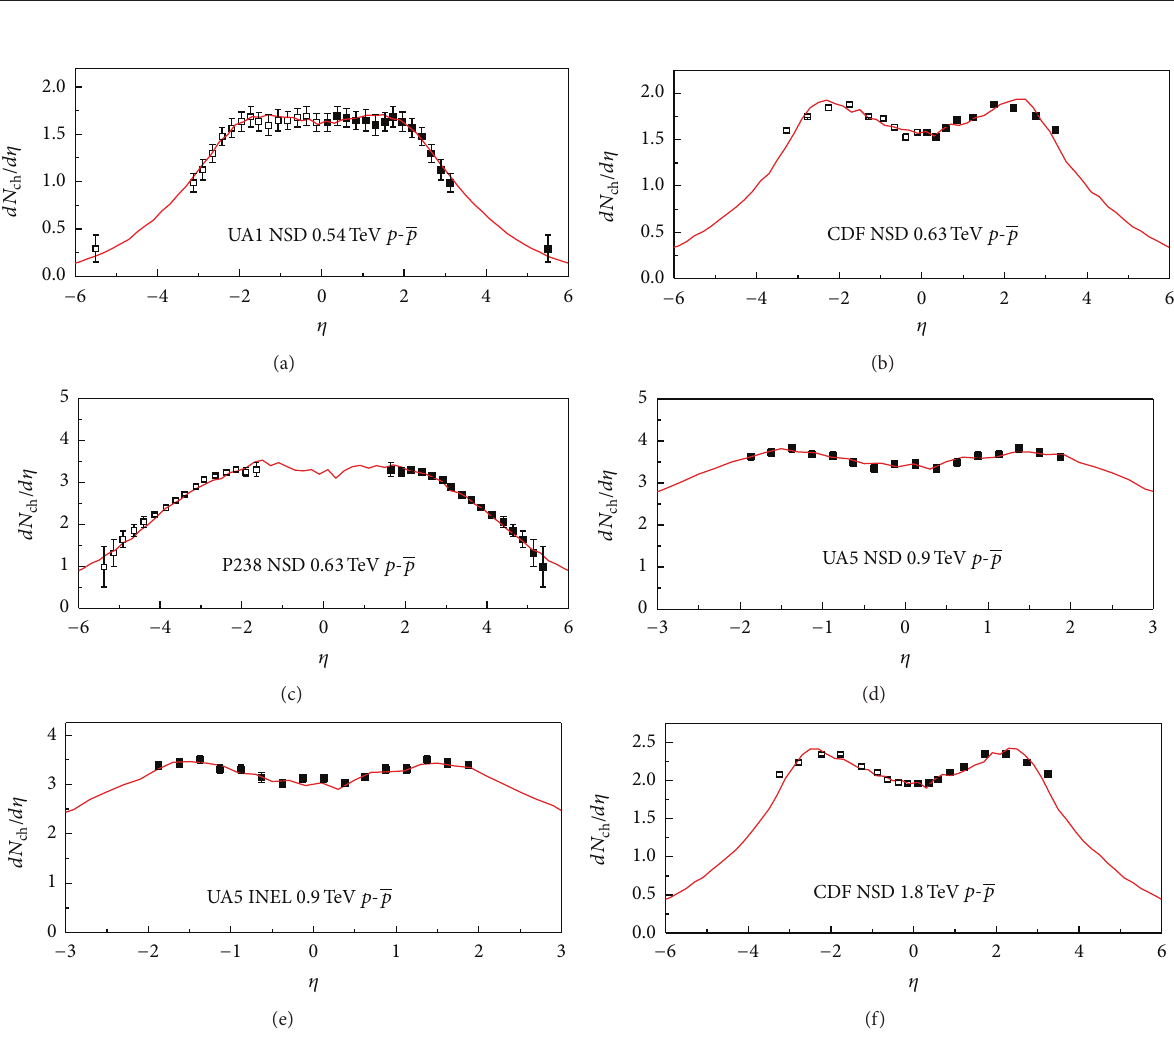
Figure 2: Pseudorapidity distributions of charged particles produced in 𝑝 - 𝑝 collisions at high energies. The solid squares and curves represent the experimental data of the UA1 [39] (a), CDF [40] ((b), (f)), P238 [41] (c), and UA5 [42] ((d), (e)) Collaborations and our fitted results, respectively, and the open squares are reflected at 𝜂 = 0 due to